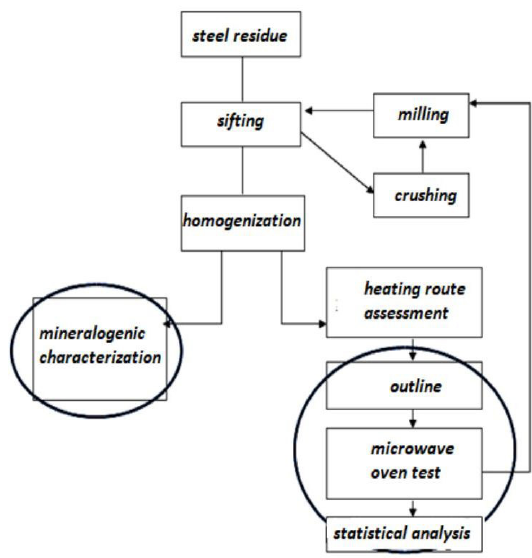
Figure 1. General flowchart for evaluating the reuse route for steel